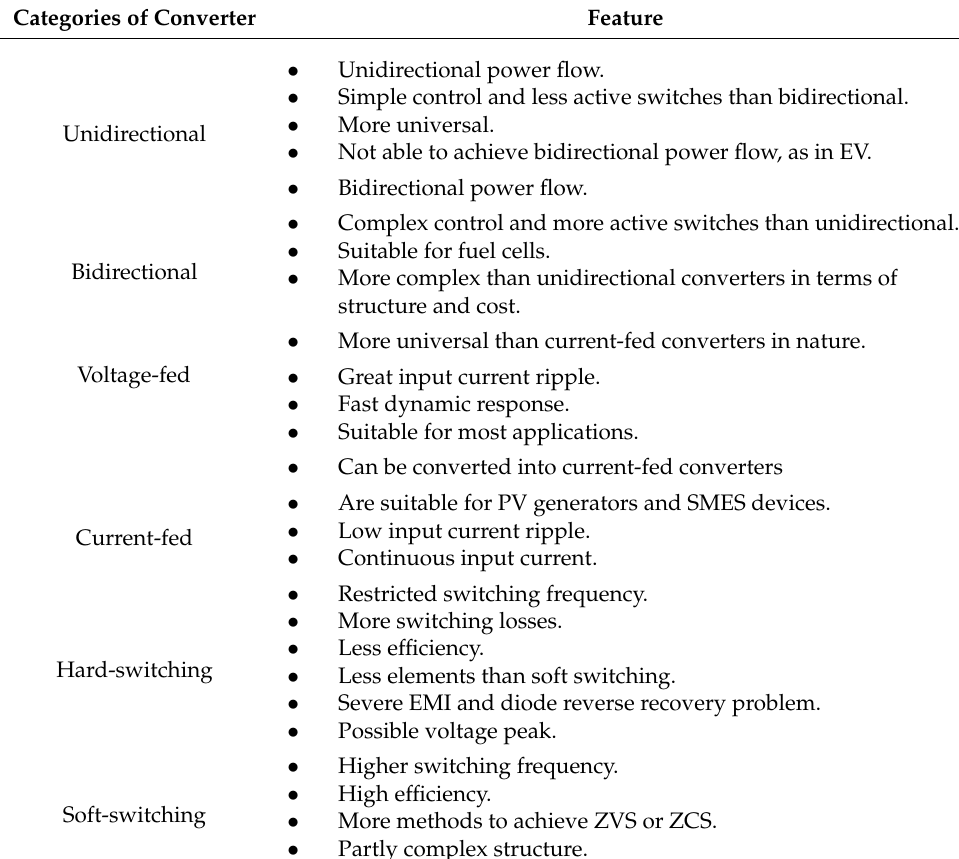
Table 2. Summary of categories of step-up and step-down DC-DC converters.